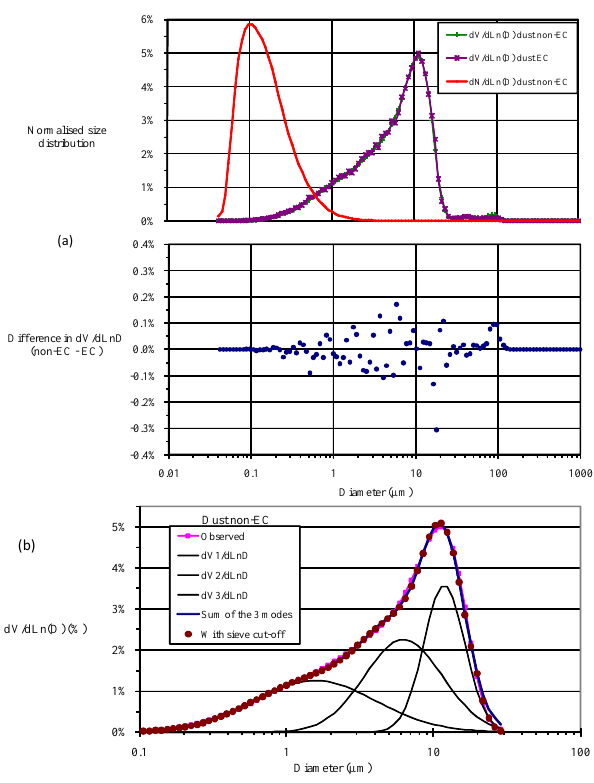
Figure 7 Figure 7 Fig. 7. (a) Normalised particle volume size distributions of non- processed and evapocondensed dust and absolute difference be- tween the two distributions (below); (b) fit of the size distribution with a sum of 3 lognormal modes and assuming a cut-off of the 20-µm mesh (see